Question: How would you classify this visualization?
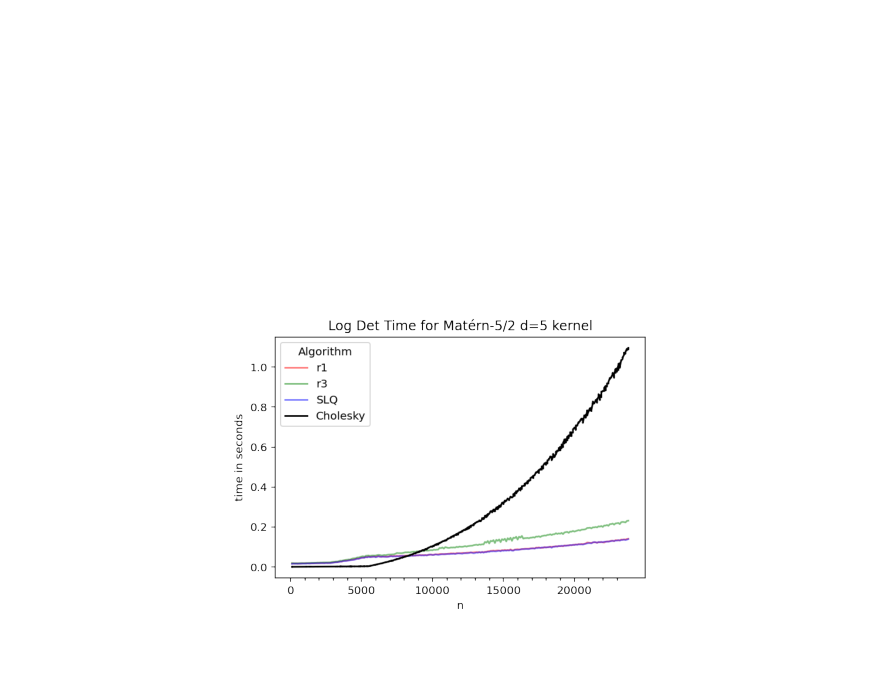
Answer: line